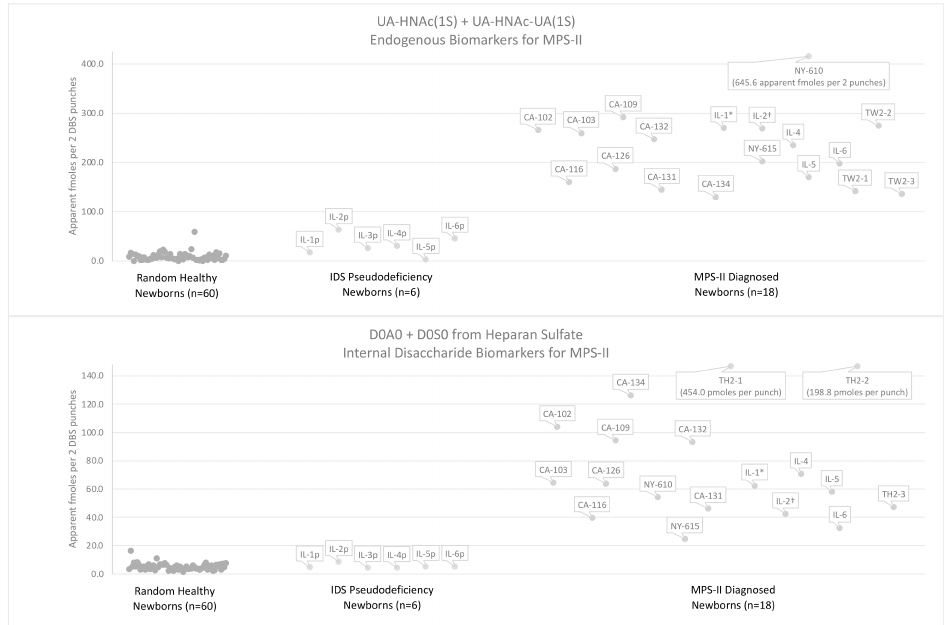
Figure 9. Levels of the MPS-II biomarkers from the internal disaccharide method (D0A0 and D0S0) and the endogenous biomarker method (UA-HNAc(1S)-late and UA-HNAc-UA(1S)) are added in newborn DBS from 60 random newborns (non-MPS), from 6 newborns with IDS pseudodeficiencies, from 16 newborns with severe MPS-II, from 1 newborn with undetermined MPS-II phenotype, and from 1 newborn with attenuated MPS-II phenotype. * DBS from patient with undetermined phenotype, † DBS from patient with attenuated